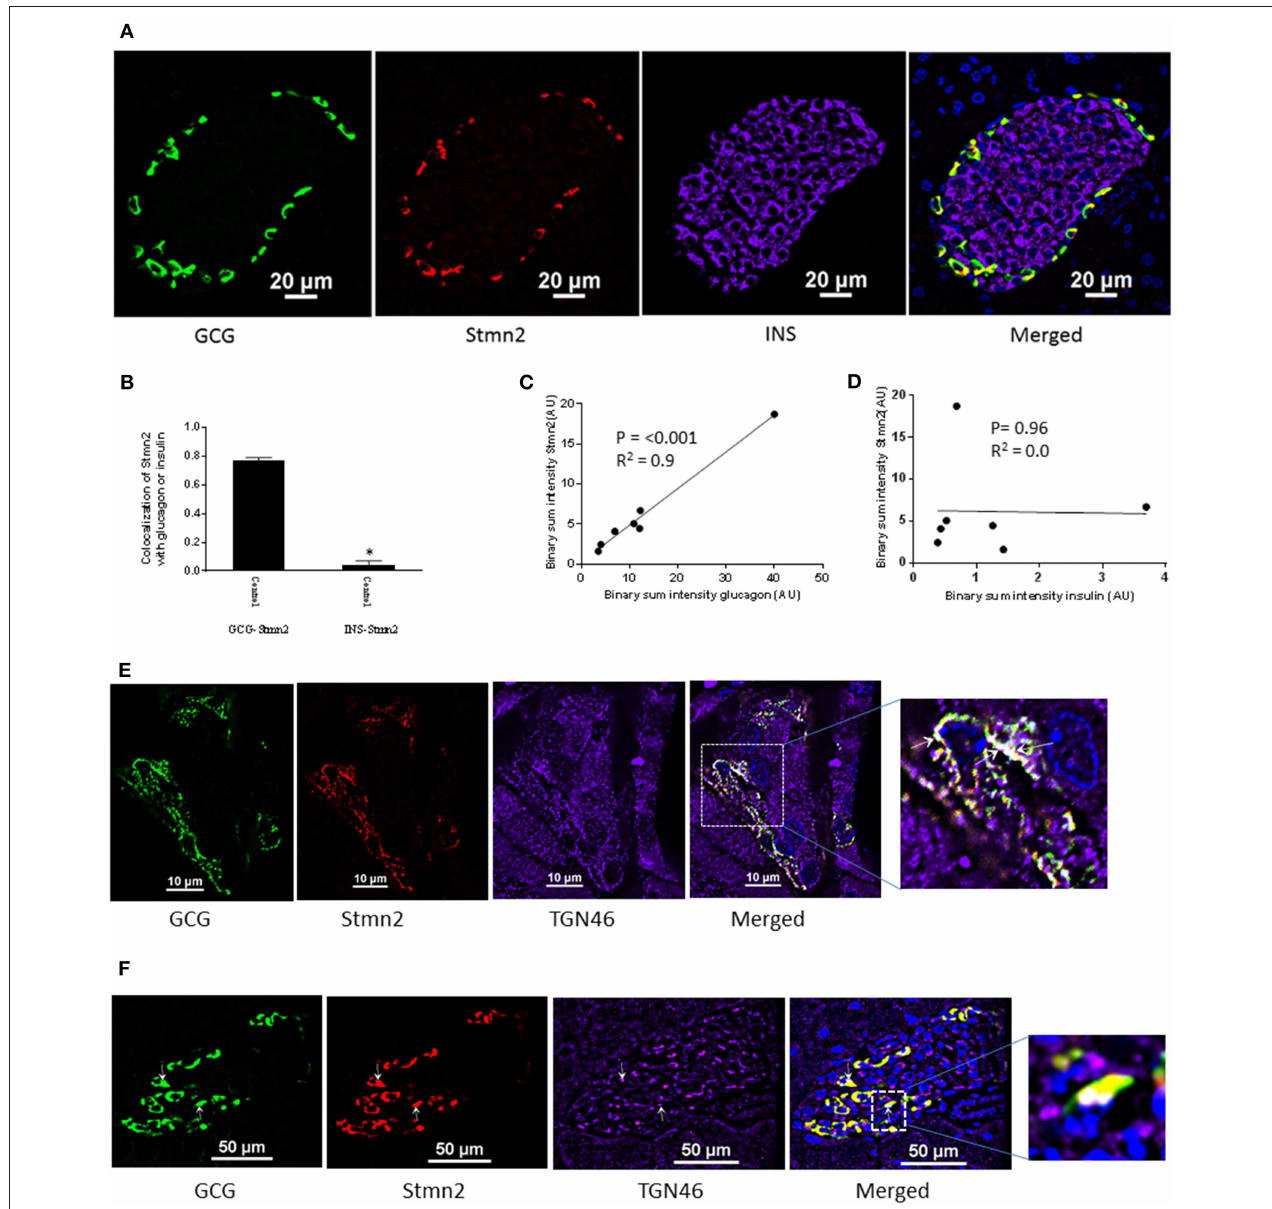
FIGURE 2 | Stathmin-2 is present in α -cells, but not β cells, in murine pancreatic islets. Pancreata of C57BL/6 mice ( n = 7; 5 µ m sections) were immunostained for glucagon (GCG), stathmin-2 (Stmn2) and insulin (INS). Images were acquired and analyzed for co-localization as described in Figure 1 . (A) Both glucagon and Stmn2 localize to the mantle of the islets, and areas of yellow in the merged image demonstrate dual positive alpha cells (glucagon + and Stmn2 + ). (B) Pearson’s correlation coefficient for colocalization of Stmn2 and glucagon or insulin. (C) Linear regression analysis predicts a strong positive correlation between the binary intensities of glucagon and Stmn2 ( p < 0.001). (D) There is no correlation between the binary intensities of insulin and Stmn2. (E,F) Colocalization of Stmn2 and the trans-Golgi marker TGN46 in murine pancreatic islets. Areas of white (arrows in the magnified panel) indicate co-localization of glucagon, Stmn2 and TGN46 in islet clusters (E) and a single islet (F)